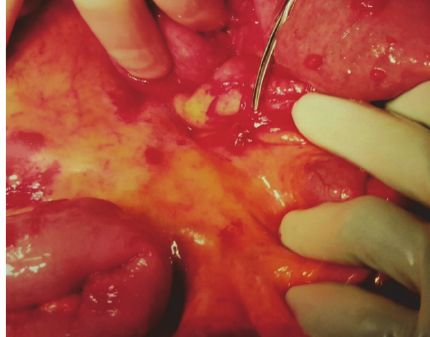
Figure 4: Intraoperative demonstration of the skin tag appearing lesion at the level of midjejunum causing inflammatory adhesions.